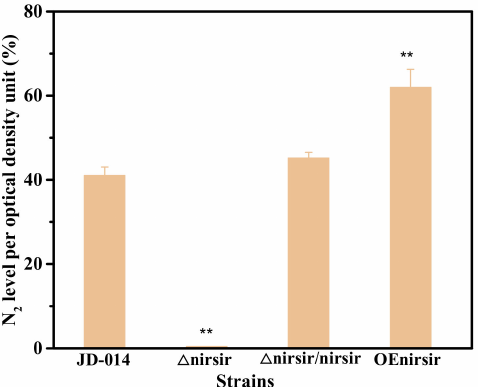
Figure 7. N 2 level between wild strain JD-014 and mutant strains. Statistical analysis was performed by using one-way analysis of variance (ANOVA) with Duncan’s test (** p < 0.01).